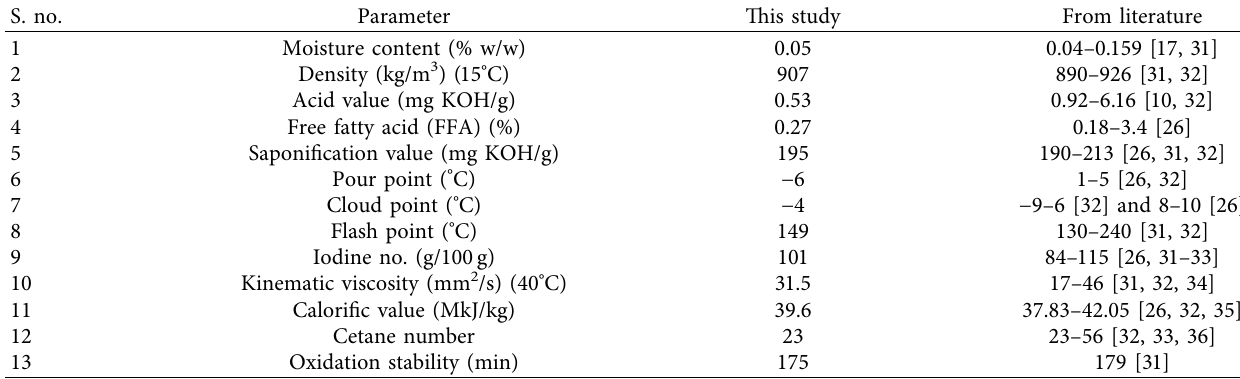
Table 2: Comparison of Jatropha oil quality parameters obtained in this study with those in the literature. S. no.